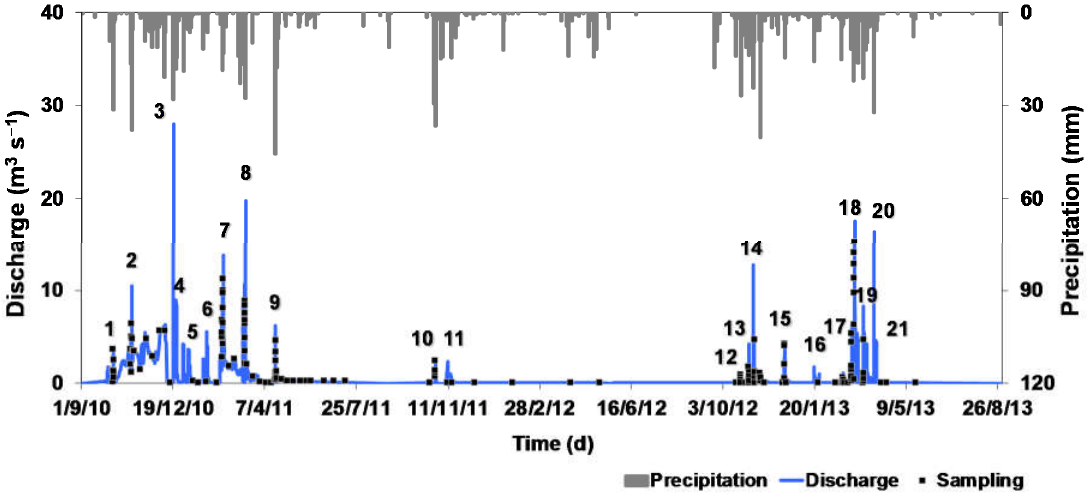
Figure 3. Precipitation and discharge at the monitoring outlet between September 2010 and August